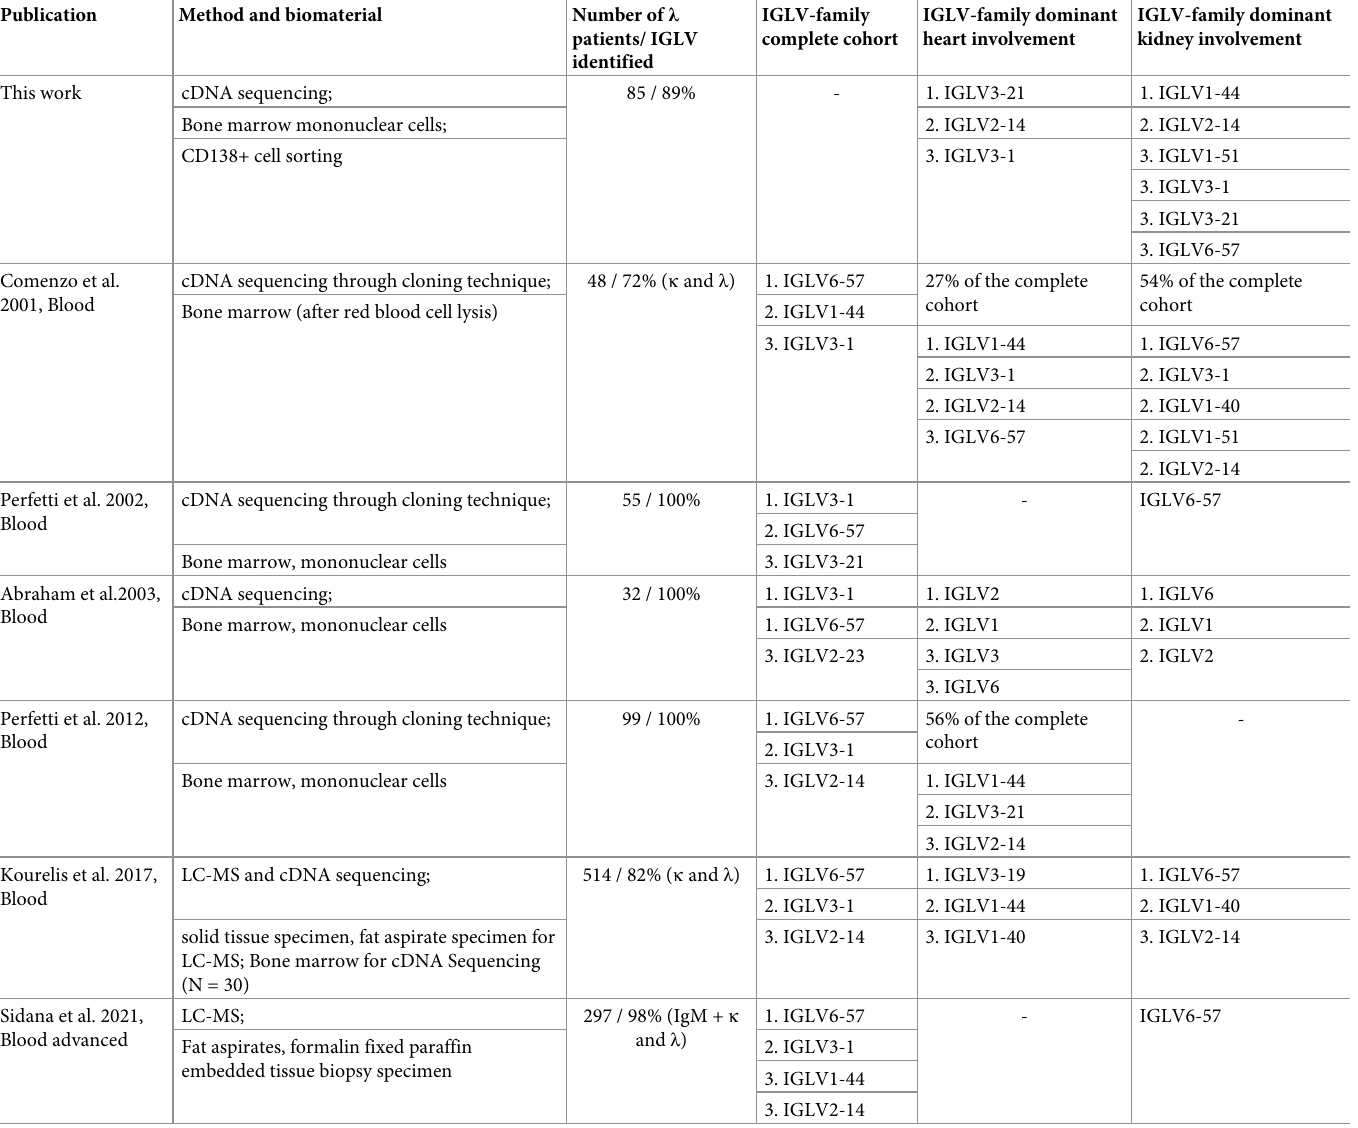
Table 5. Comparison between previously published data and data from this